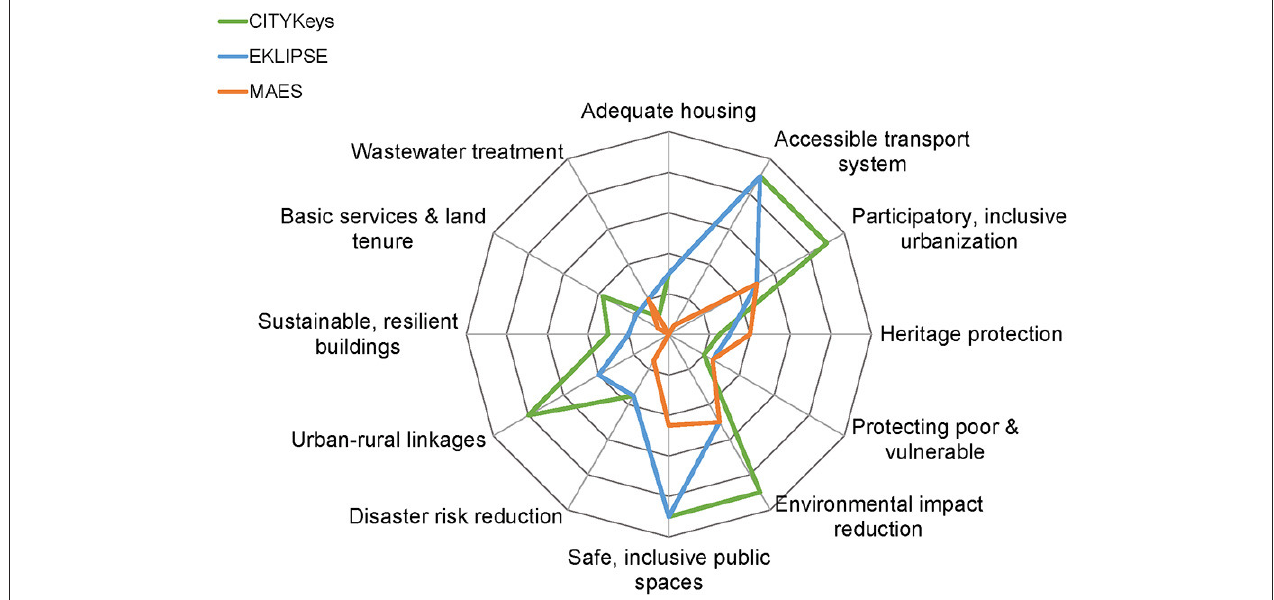
FIGURE 1 | Visual representation of the degree to which the MAES (Maes et al., 2016), EKLIPSE (Raymond et al., 2017), and CITYkeys (Bosch et al., 2017) frameworks, respectively, address the key indicators of sustainable urban development as defined by UN-Habitat et al.,